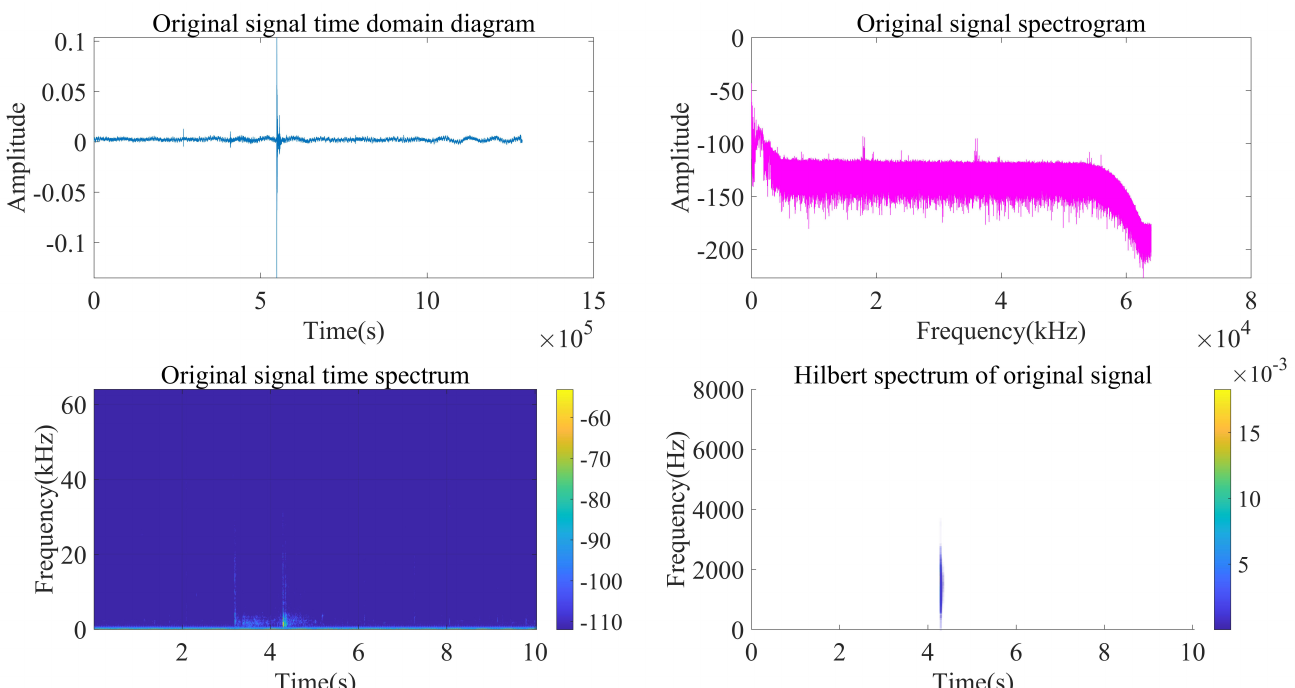
Figure 15. Second-channel acquisition signal processing and analysis.